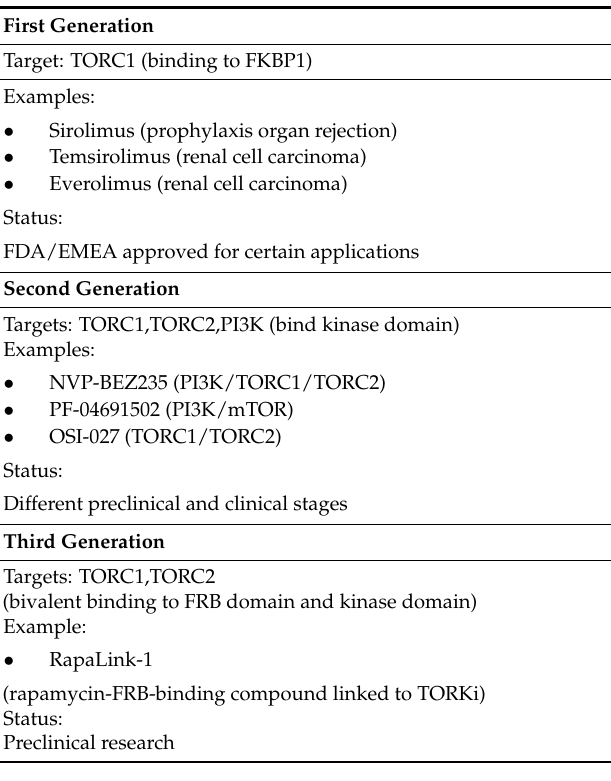
Table 2. Pharmacological use of different mTOR inhibitor classes. The table displays the characteristics of the corresponding inhibitor family and lists important